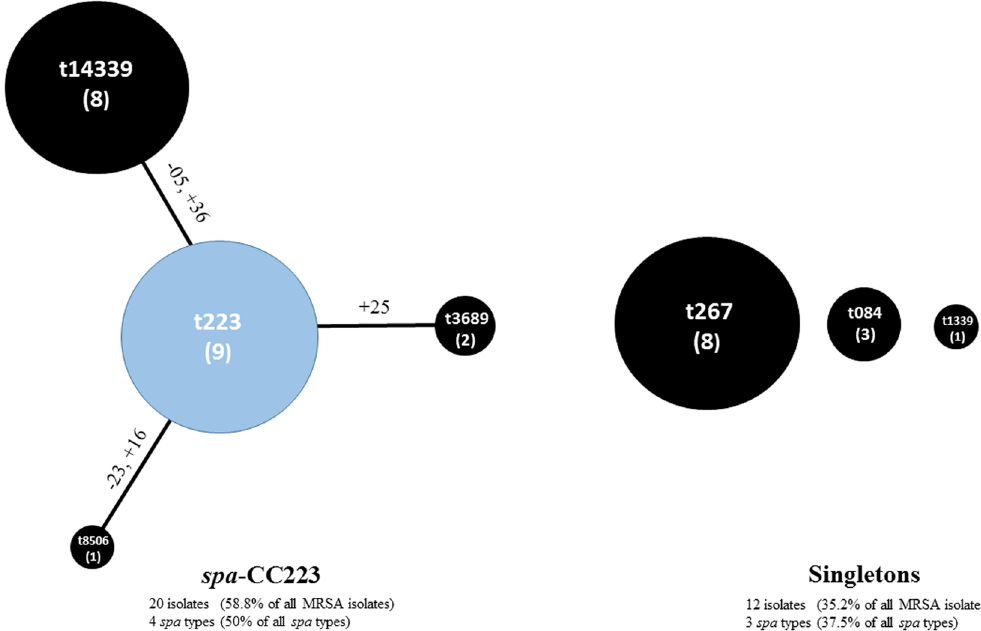
Figure 1. Population structure of the tested MRSA isolates ( n = 34) based on BURP analysis. This analysis was performed using the Based Upon Repeat Pattern (BURP) algorithm of the Ridom StaphType software (Ridom GmbH, Würzburg, Germany) at a cost setting of ≤ 5 and excluding spa -types with 5 or fewer repeats. Each dot represents a different spa type, with the diameter of the dot being proportional to the quantity of the corresponding spa type. Clusters of linked spa types correspond to spa clonal complexes ( spa -CCs). The predict founder of a cluster (which was used for defining the cluster) is shown in blue, while the others in black. Near the lines of connection, the mutations involved in the transition from a spa type to the next one are reported in detail. All DNA changes are meant to occur from the founder to the periphery. Legend: numbers along the lines refer to the repeat sequence involved in the mutation; + indicates the acquisition of a repeat sequence; - indicates the loss of a repeat sequence; within circles the numbers of the strains of each CC appear between brackets. In summary, the analysis identified a single clonal complex ( spa -CC223) comprising spa types t223, t14339, t3689, and t8506; n = 20 isolates, and accounted for 58.8% of all tested MRSA isolates, as well as 3 singletons (t267, t084, and t1339; n = 12 isolates, 35.2%), while excluded 2 isolates (t380, 5.8%) from the clustering, as they consisted of four repeat units